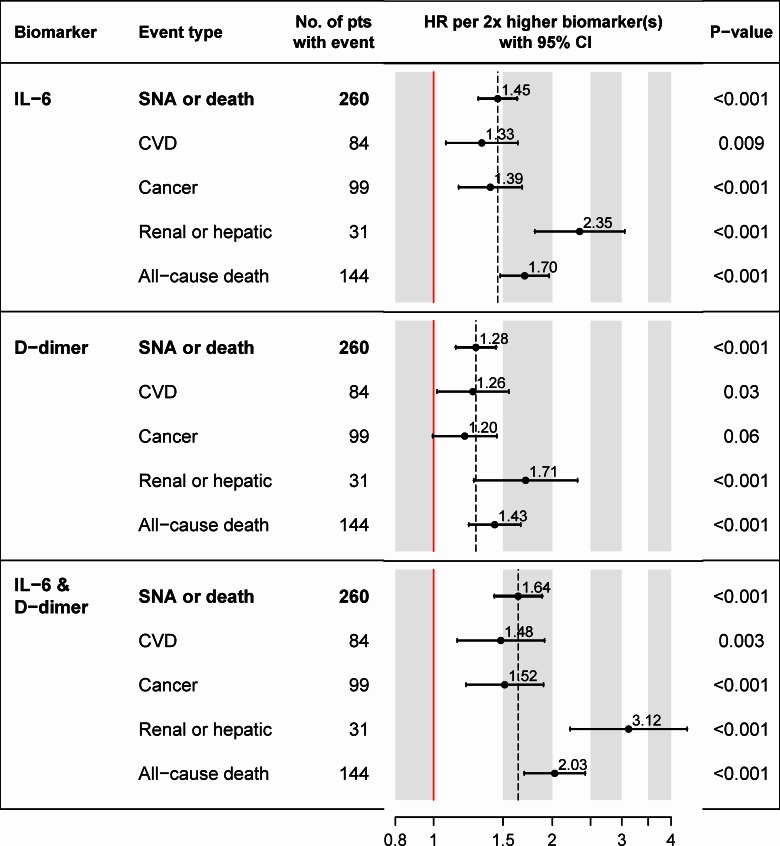
Estimated hazard ratios (HR) for the composite endpoint of serious non-AIDS or death (SNA/death) and its components.Hazard ratios are estimated per 2x higher level of IL-6 and D-dimer, with 95% confidence intervals. Two times higher biomarker levels corresponds to 1 unit higher on the log2 biomarker scale, and 0.49 units higher for the IL-6 & D-dimer score. Hazard ratios were estimated in proportional hazards models adjusted for age, sex and study. Footnotes: Of the 144 deaths, 37 were due to non-AIDS cancer, 33 CVD, 11 non-cancer hepatic disease, 1 renal failure, 15 AIDS-related, 9 due to violence, accident or suicide, 38 due to other or unknown causes. Abbreviations: CI = confidence interval; CVD = cardiovascular disease (myocardial infarction, stroke, and death due to CVD); HR = hazard ratio.